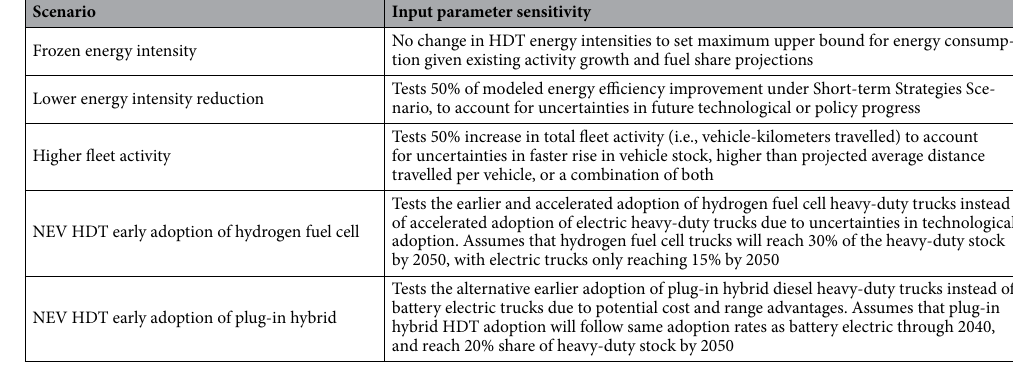
Table 3. List of sensitivity scenarios.